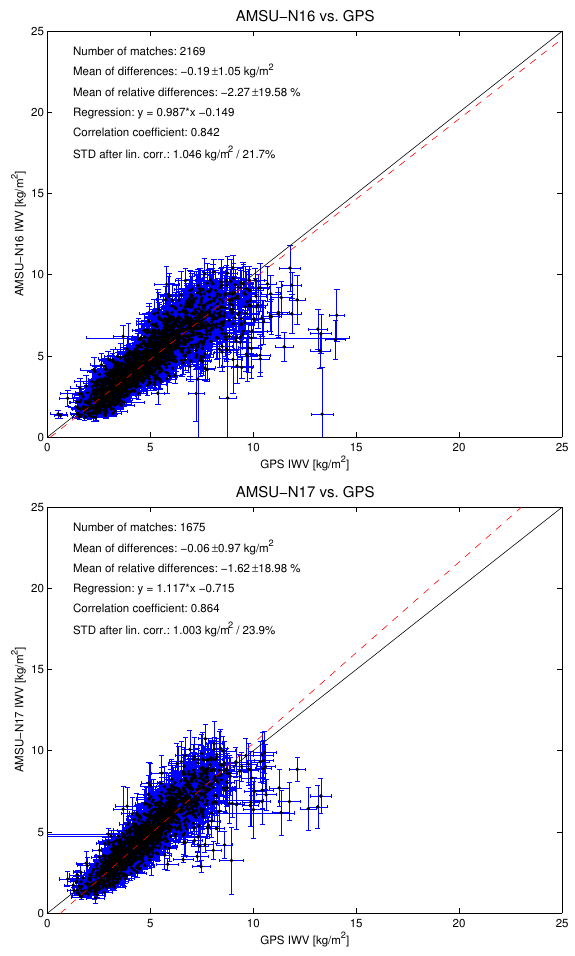
Fig. 8. Scatterplots of other datasets versus GPS: N16 AMSU-B (top) and N17 AMSU-B